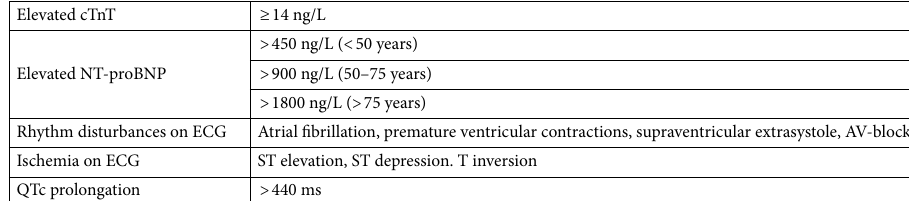
Table 3. Definitions of cardiac and other complications. AV atrioventricular, cTnT cardiac troponin T, NT-proBNP N ‐ terminal pro ‐ B ‐ type natriuretic peptide, QTc corrected QT